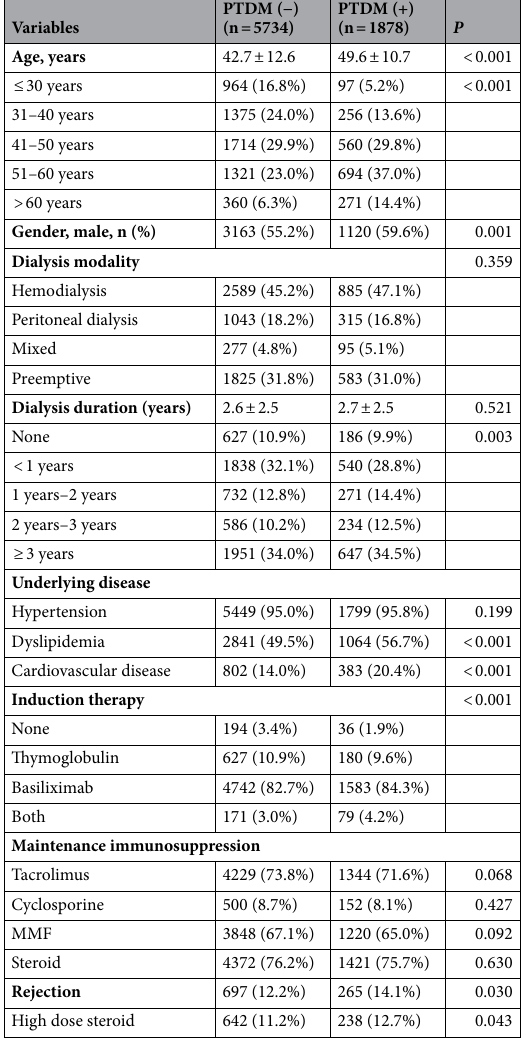
Table 1. Baseline characteristics of total enrolled participants according to PTDM. PTDM New onset diabetes after kidney transplantation, MMF mycophenolate